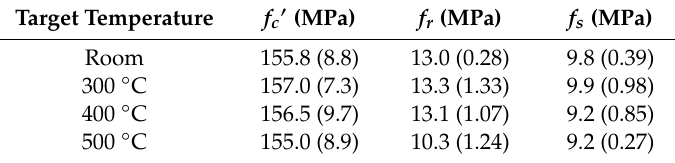
Figure 6. Rupture of the specimen after high temperature: ( a ) 15 ◦ C / min heating rate and target temperature of 600 ◦ C, ( b ) 10 ◦ C / min heating rate and target temperature of 600 ◦ C, ( c ) 5 ◦ C / min heating rate and target temperature of 600 ◦ C, ( d ) 2 ◦ C / min heating rate and target temperature of 600 ◦ C, and ( e ) 2 ◦ C / min heating rate and target temperature of 500 ◦ C. Table 11. Results of 56-day hardened concrete properties at room